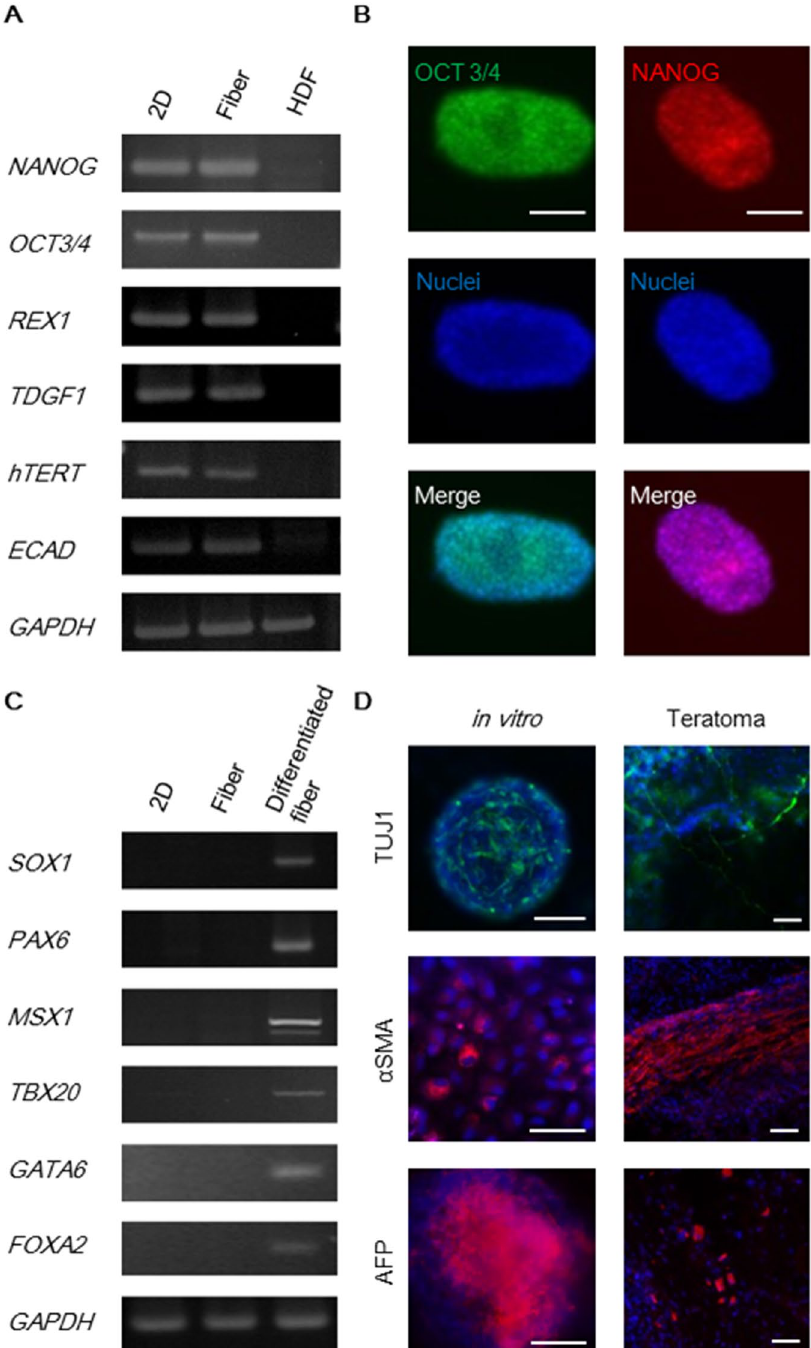
Figure 6. Characterization of the human iPS cells cultured in the core-shell microfiber culture system. ( A ) RT-PCR analysis of pluripotency-associated marker genes. 2D, cells cultured on a Matrigel-coated culture plate (positive control); Fiber, cells after culture for 44 days (11 passages) in the core-shell microfiber culture system; and HDF, human dermal fibroblasts (negative control). Raw data of gels are presented in Supplementary Figure S10. ( B ) Fluorescence images of cell aggregations stained for OCT3/4 (green) or NANOG (red) after culture for 44 days (11 passages). Nuclei were stained with Hoechst 33342 (blue). Scale bar: 100 μ m. ( C ) RT-PCR analysis of differentiation marker genes. 2D, cells cultured on a Matrigel-coated culture plate (positive control); Fiber, cells after culture for 44 days (11 passages) in the core-shell microfiber culture system; and Differentiated fiber, cells cultured in the core- shell microfiber culture system with differentiation-induction medium after maintaining the culture for 48 days (12 passages) in the culture system. Full-length gels are presented in Supplementary Figure S11. ( D ) Fluorescence images of the in vitro differentiated fibers and teratoma using cells cultured for more than 32 days (8 passages) in the core- shell microfiber culture. The cells and tissues were stained with an ectoderm marker (TUJ1: green), a mesoderm marker ( α SMA: red), an endoderm marker (AFP: red), and Hoechst 33342 (nuclei: blue). Scale bar: 100 μ